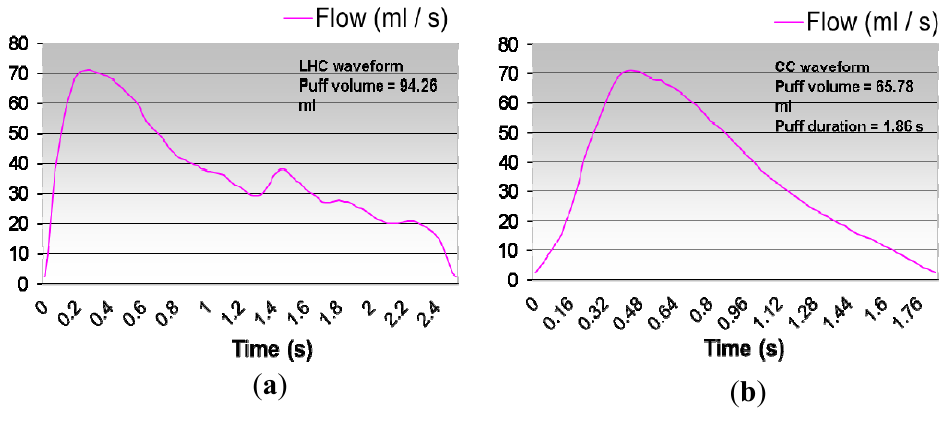
Figure 3. Single puff profiles: ( a ) A typical LHC-puffing waveform (adapted from [13], with permission from Elsevier); ( b ) A typical conventional cigarette puffing